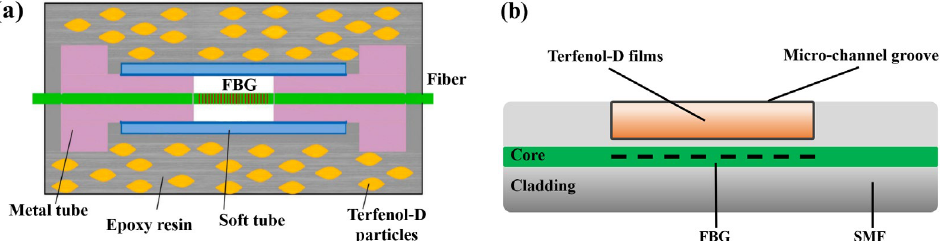
Figure 11. Magnetic field fiber sensors based on the wrapped–type transducer with ( a ) a sensitivity- enhancement structure (reprinted with permission from Ref. [83], 2022, Elsevier) and ( b ) a micro- channel groove [86].